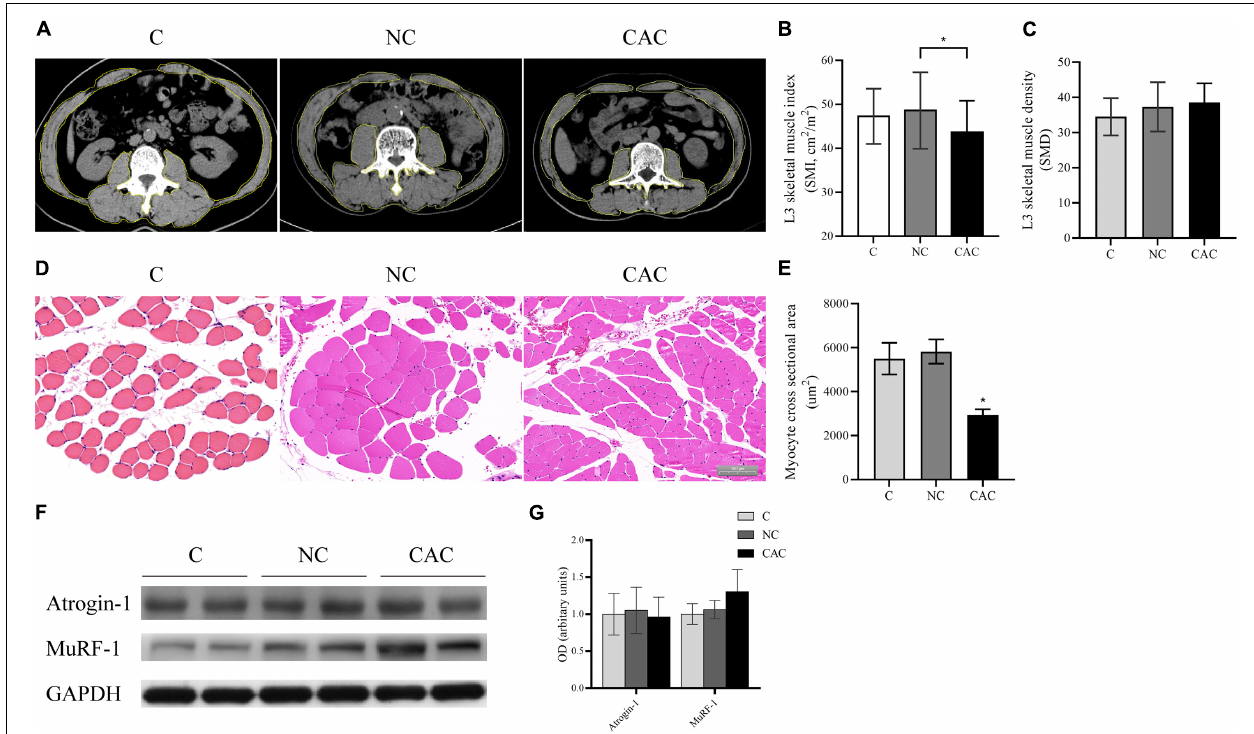
FIGURE 1 | (A) Typical images of L3 vertebra from CT scan. Muscle content is outlined with a yellow line. (B) Quantification of SMI. (C) Quantification of SMD. (D) Typical HE staining images of fibers of rectus abdominis ( n = 5 for NC and CAC groups; n = 3 for C group). (E) Quantification of CSA. (F) Levels of Atrogin-1 and MuRF-1 by Western blot. (G) Quantification of (F) . SMI, skeletal muscle index; SMD, skeletal muscle density; C, control, patients with benign disease; NC, patients of non-cachexia; CAC, cancer patients with cachexia. * p < 0.05. Data are displayed as mean ± standard